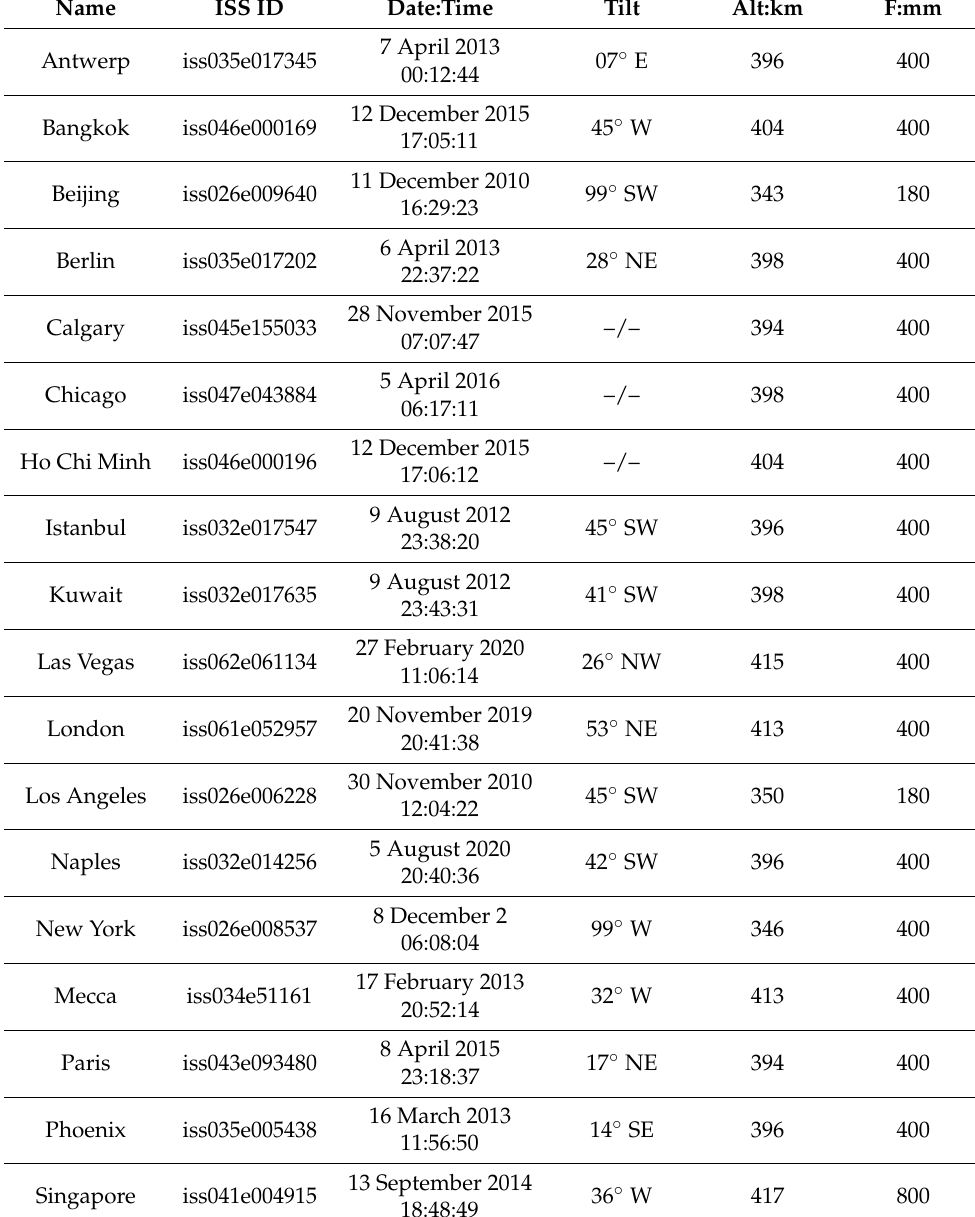
Table 1. ISS photo